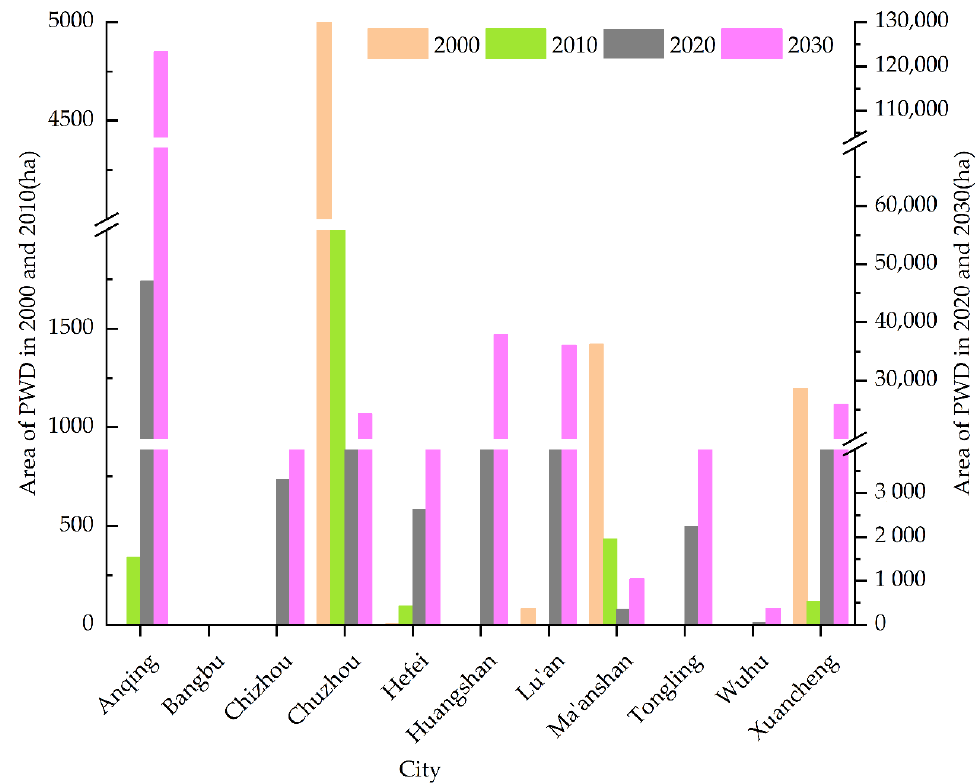
Figure 6. Occurrence area of PWD in different periods in cities of Anhui Province.